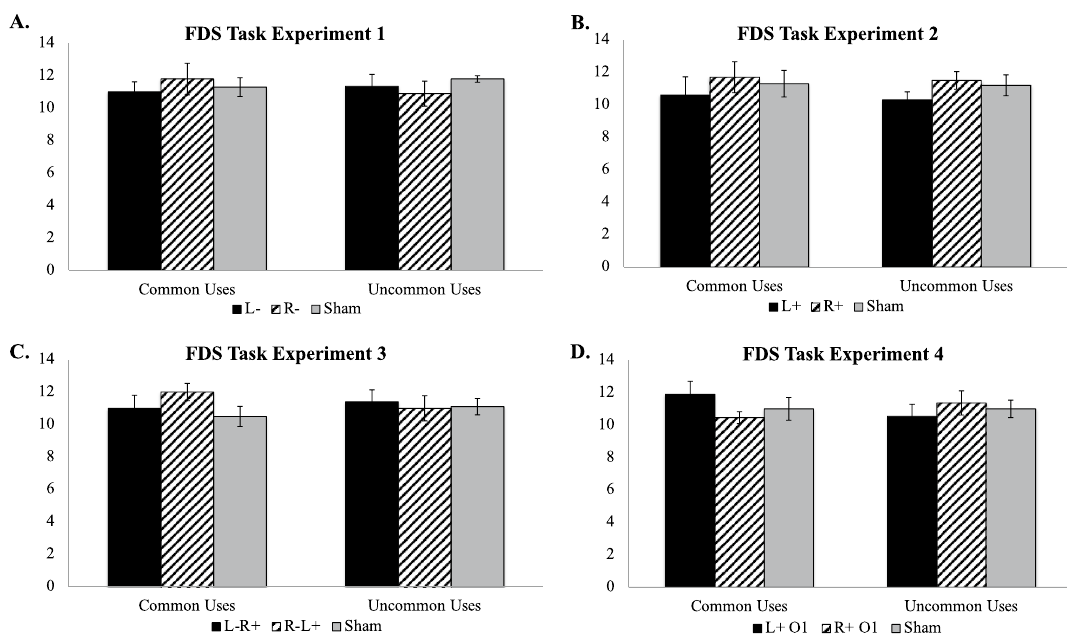
Figure 4. Forward Digit Span (FDS) task mean accuracy for Experiments 1–4 by task and stimulation condition. ( A ) FDS task mean accuracy for Experiment 1; ( B ) FDS task mean accuracy for Experiment 2; ( C ) FDS task mean accuracy for Experiment 3; ( D ) FDS task mean accuracy for Experiment 4; L- = cathodal tDCS over left ventrolateral PFC; R- = cathodal tDCS over right ventrolateral PFC. L + = anodal tDCS over left ventrolateral PFC; R + = anodal tDCS over right ventrolateral PFC. L-R + = cathodal tDCS over left ventrolateral PFC with concurrent anodal tDCS over right ventrolateral PFC; R-L + = cathodal tDCS over right ventrolateral PFC with concurrent anodal tDCS over left ventrolateral PFC. L + O1 = anodal tDCS over left occipitotemporal cortex; R + O2 = anodal tDCS over right occipitotemporal